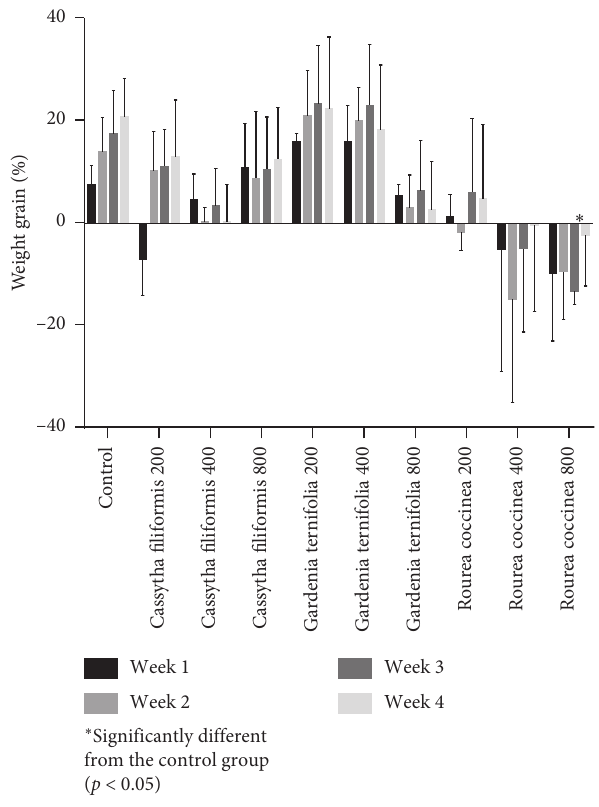
Figure 2: Sensitivity of Artemia salina larvae to the studied plants. (a) Cassytha filiformis ; (b) Rourea coccinea ; (c) Gardenia ternifolia ; LC lethal mean concentration.